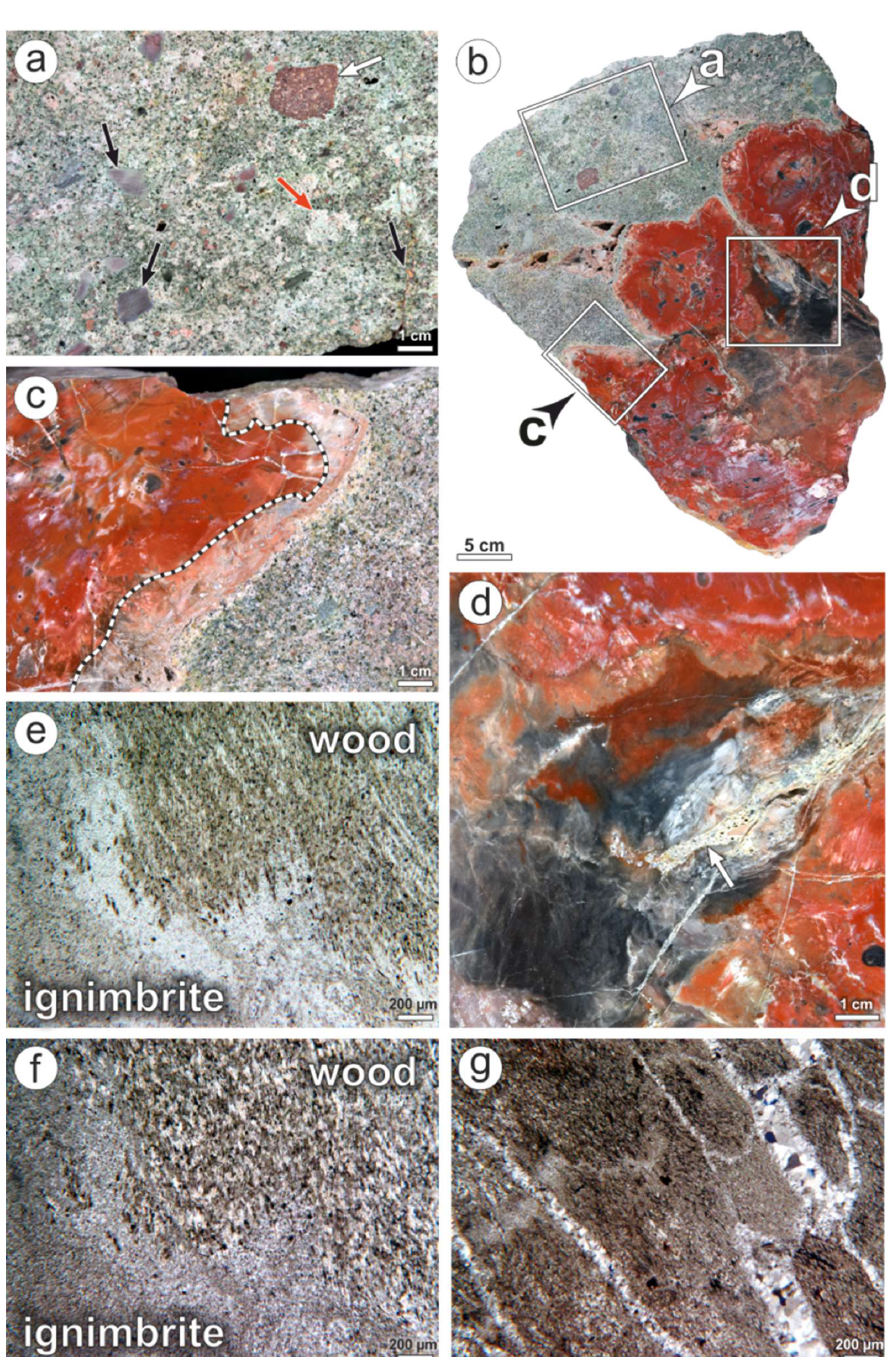
Figure 6. Features of K6562 and its host rock from Wendishain. ( a ) Ignimbrite consisting of wood fragments (black arrows), pumice (red arrow) and lithics (white arrow). ( b ) Cross-section showing silicified wood (red) with adhering ignimbrite (green). ( c ) Color zonation of the wood with an outer greyish-white to rose-colored zone 1, and an inner orange zone 2 (dotted line as border). ( d ) Color zonation of the wood with orange zone 2, and dark grey to brown zone 3. Note fracture fillings with ignimbrite (arrow). ( e ) Gradual transition from wood into ignimbrite; PPL image. ( f ) Same view as ( e ); XPL image. ( g ) Zone 2; XPL image. Note coarse-crystalline quartz in the fractures.